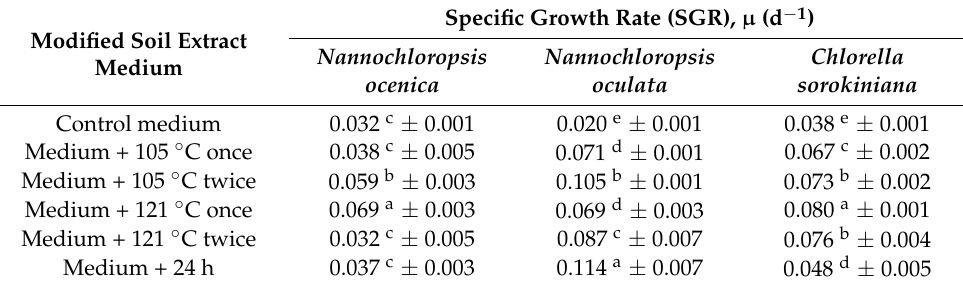
Table 4. Specific growth rate, µ of Nannochloropsis ocenica , Nannochloropsis oculata , and Chlorella sorokiniana in different modified soil extract